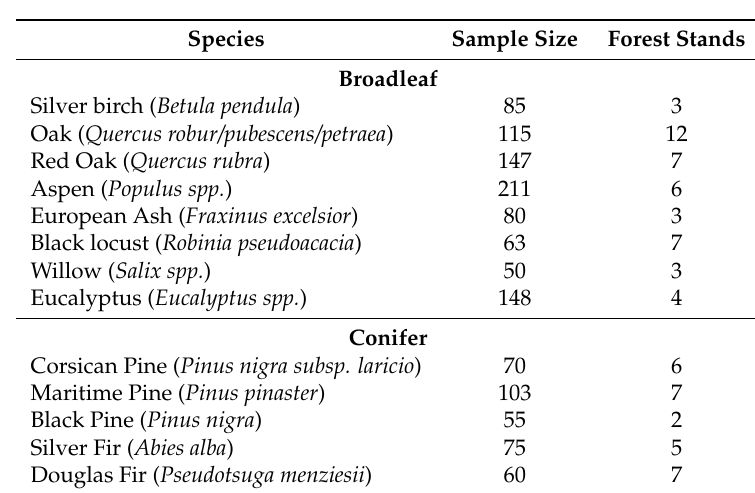
Table 1. List of tree species with their sample size, in pixels, collected during field surveys ( n = 1262). The number of forest stands in which the samples were collected is also provided. Stand delimitation is based on the French National Forest Inventory database (IGN BDForêt ®